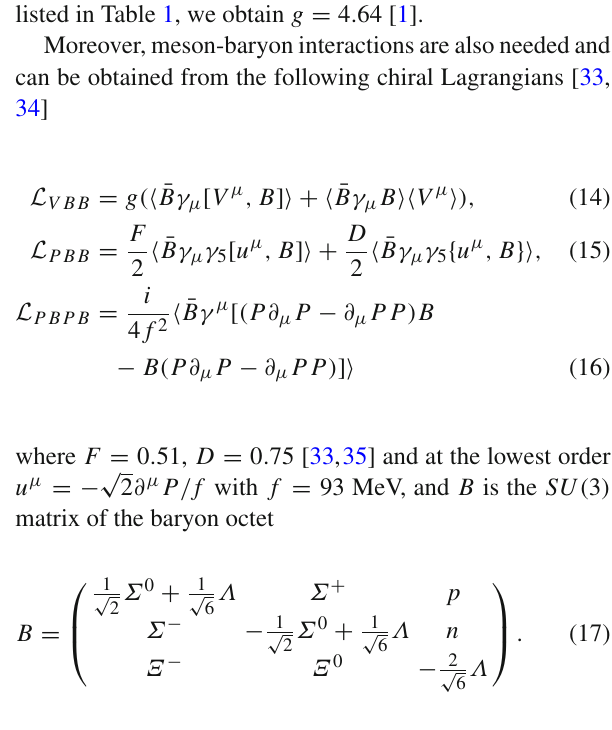
Table 1 Masses of the particles needed in the present work (in units of